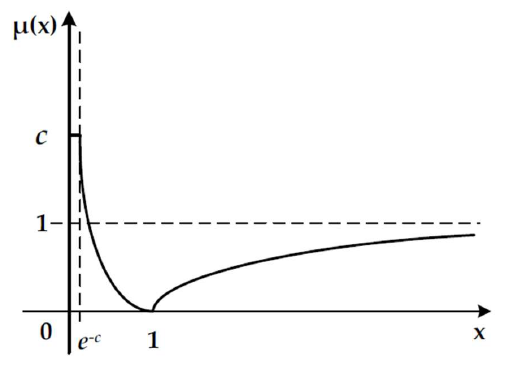
Figure 3. The rewarding excellence and punishing inferiority function.